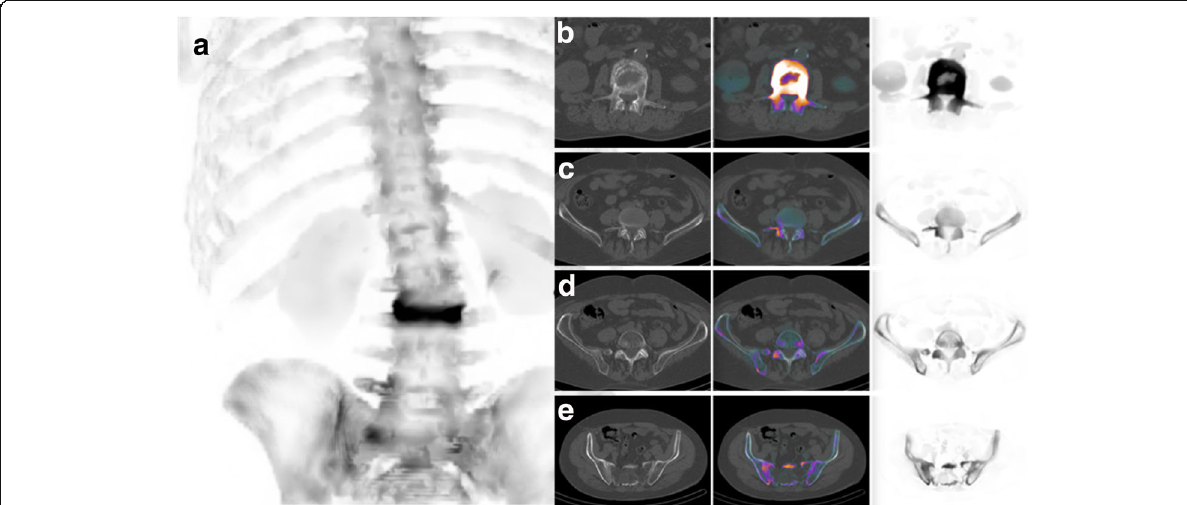
Fig. 1 Example of an xSPECT Bone reconstruction providing SPECT images with bone anatomy appearance. The xSPECT Bone® maximum intensity projections (MIP) combines scintigraphic data with morphological data from the computed tomography. In this example, the scintigraphy was performed in order to explore an acute low back pain. The exclusive use of the xSPECT Bone® MIP ( a ) makes it possible to visualize on one image an uptake related to a fracture of a vertebral body responsible for spinal angulation, to identify the vertebra concerned (L3), to visualize an uptake localized on the fifth right transverse process extended to the zygapophysial joint, and to visualize an uptake of the last right zygapophysial joint and an uptake asymmetry of the sacroiliac joints. Transaxial image analysis confirms the fracture of the L3 vertebral body ( b ) and specifies its extension toward the pedicles. It also confirms the uptake of the fifth right transverse process ( c ), of the last right zygapophysial joint ( d ) and the uptake asymmetry of the sacroiliac joints ( e